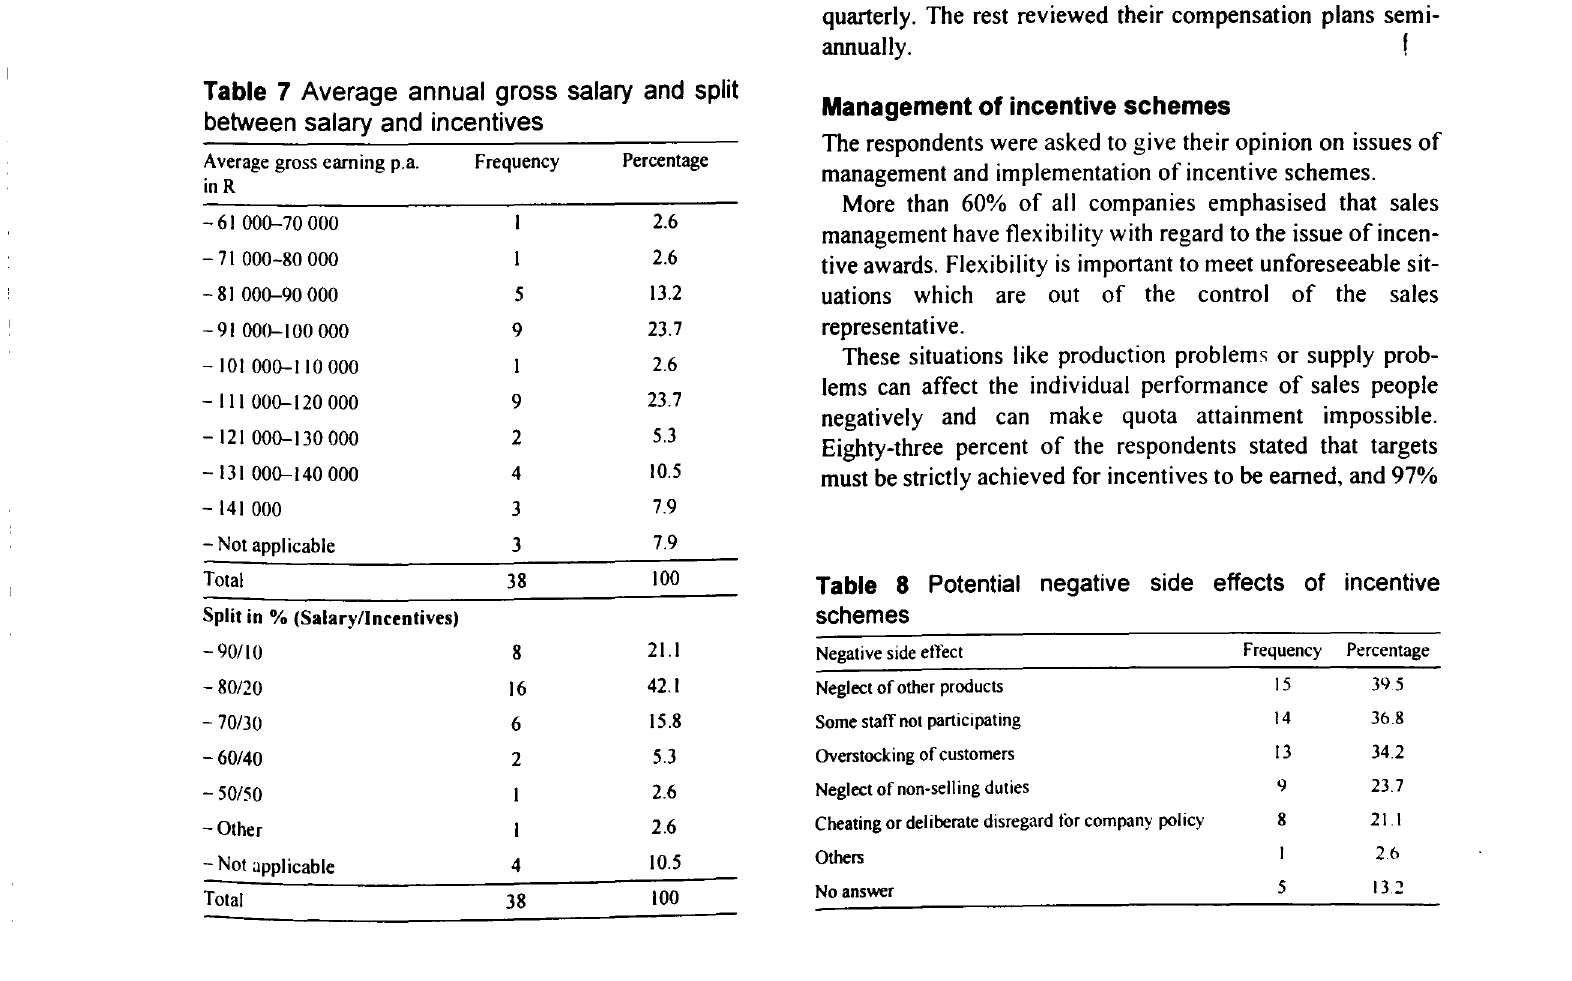
Table 7 Average annual gross salary and